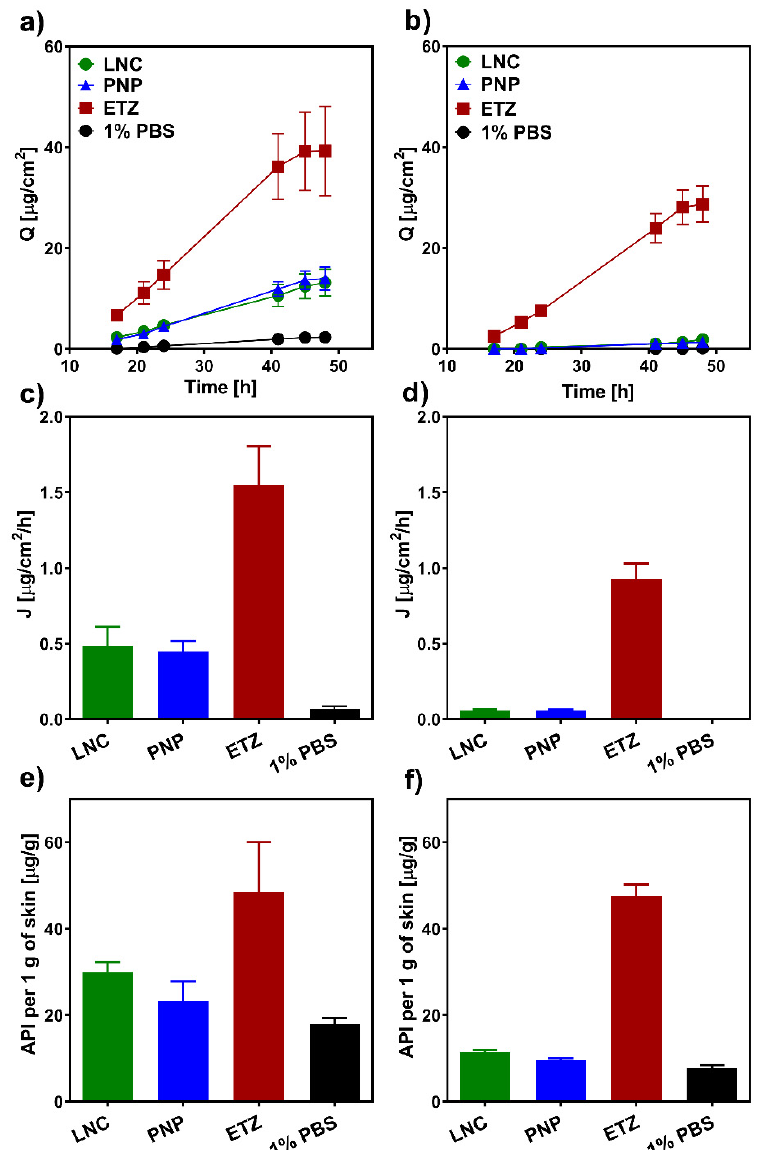
Figure 4. Permeation characteristics of hydrocortisone from the ex vivo permeation study. The left column (graph ( a , c , e )) represents the results obtained on porcine skin, the right column (graph ( b , d , f )) contains results from the human skin. The first row (graph ( a , b )) depicts permeation profiles as the dependency of cumulative amount on time. The second row (graphs ( c , d )) contains flux values of HC liberated from various nanoformulations. The bottom row (graph ( e , f )) shows the entrapment of HC in the skin presented as the amount of HC per 1 g of the skin. n ≥ 12.